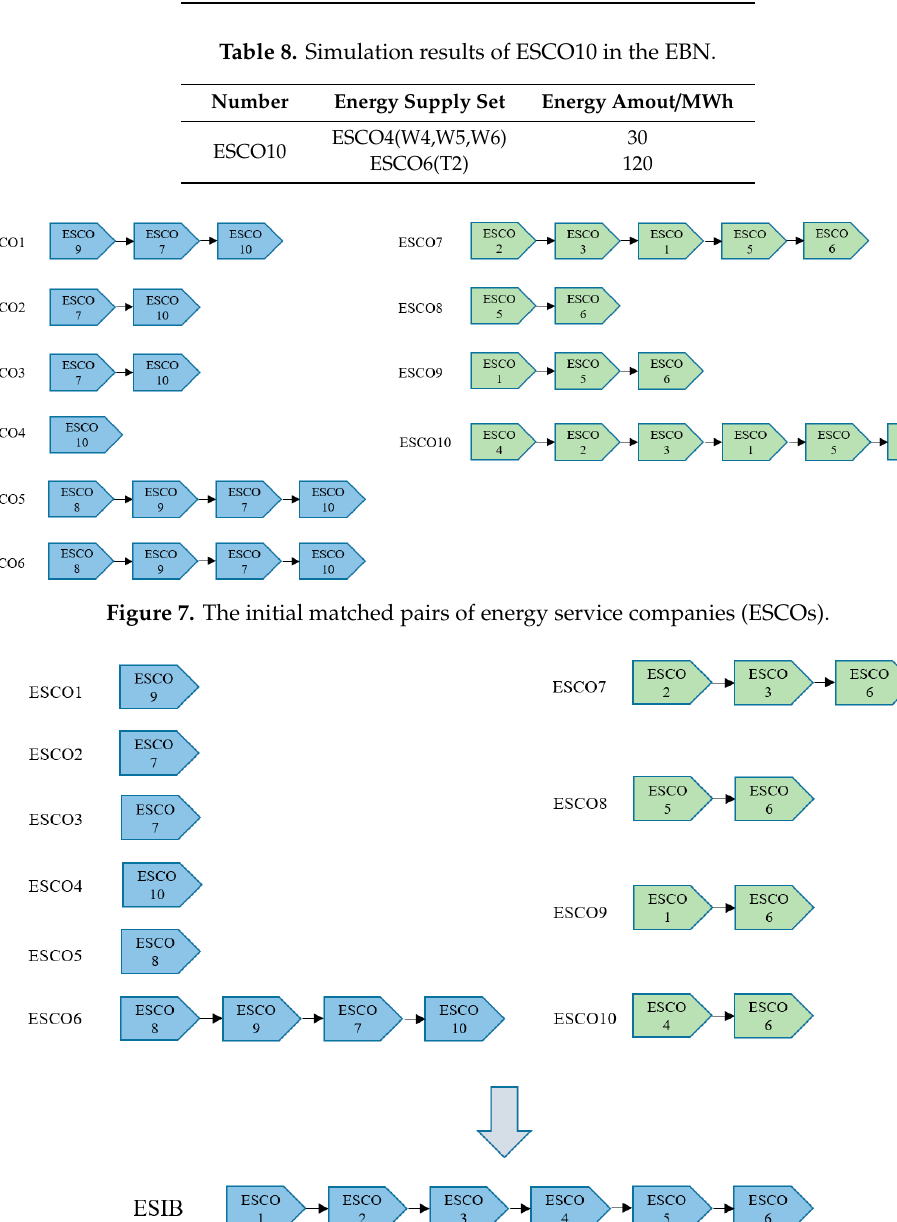
Figure 9. The energy scheduling process of EBN ‐ IESCOM. Four types of ESCOs are examined to investigate the energy scheduling process of EBN ‐ IESCOM with different parameters of buy nodes. (1) ESCO7 with household energy demand: The stability of energy demand is 0.5, all ESCOs meet the condition, except ESCO4. According to the established smart contract considering multiple factors including price, stability, and environment, ESCO7 searches for the best ‐ matched energy supply nodes through ESIB. As shown in Figure 9, the ESCO2, ESCO3, ESCO1, ESCO5, and ESCO6 constitute the supply set of ESCO7 orderly. However, with the smart contracts, the ETB of ESCO7 is ESCO2, ESCO3, and ESCO6, finally, and the energy amount of each ESCO is 45 MW, 50 MW, and 25 MW. (2) ESCO8 with emergent energy demand: The stability of energy demand is very high to ensure the reliability of energy supply, which results in that only ESCO5 and ESCO6 can reach the requirements. Due to the high degree of environmental protection, ESCO5 has the priority to carry on energy trade. The process of ETB formation of ESCO8 also verifies the conclusion. The ETB of ESCO8 is ESCO5 and ESCO6, and the energy amount of each ESCO is 800MW and 100MW.